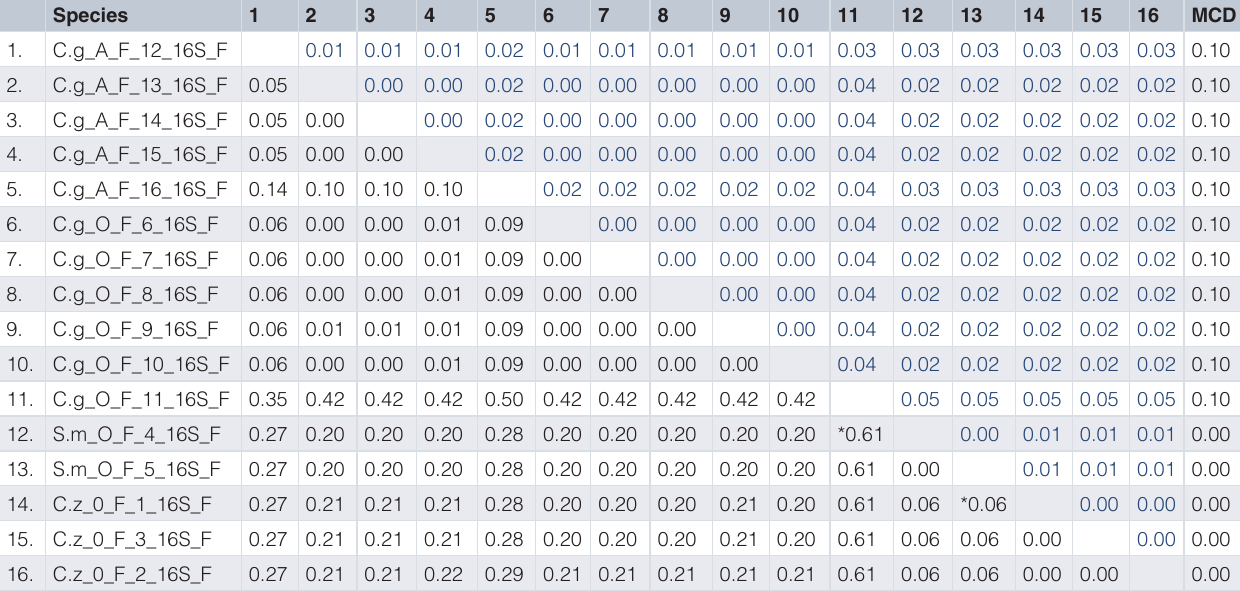
Table 6. 16S rRNA estimates of pairwise of genetic distances between C. gariepinus , C. zillii and S. melanotheron based on Kimura 2-Parameter model. Pairwise conspecific divergence was denoted by the number of base substitutions per site between species (below diagonal) with their corresponding standard error estimate(s) (above the diagonal). Completed deletion of all codon positions (1st, 2nd, 3rd and Noncoding), gaps and missing data were eliminated and were employed in this analysis. All positions. *Genetic distance resulting from intraspecific variation between C. gariepinus - S. melanotheron and C. zillii – S. melanotheron . Mean conspecific divergence,